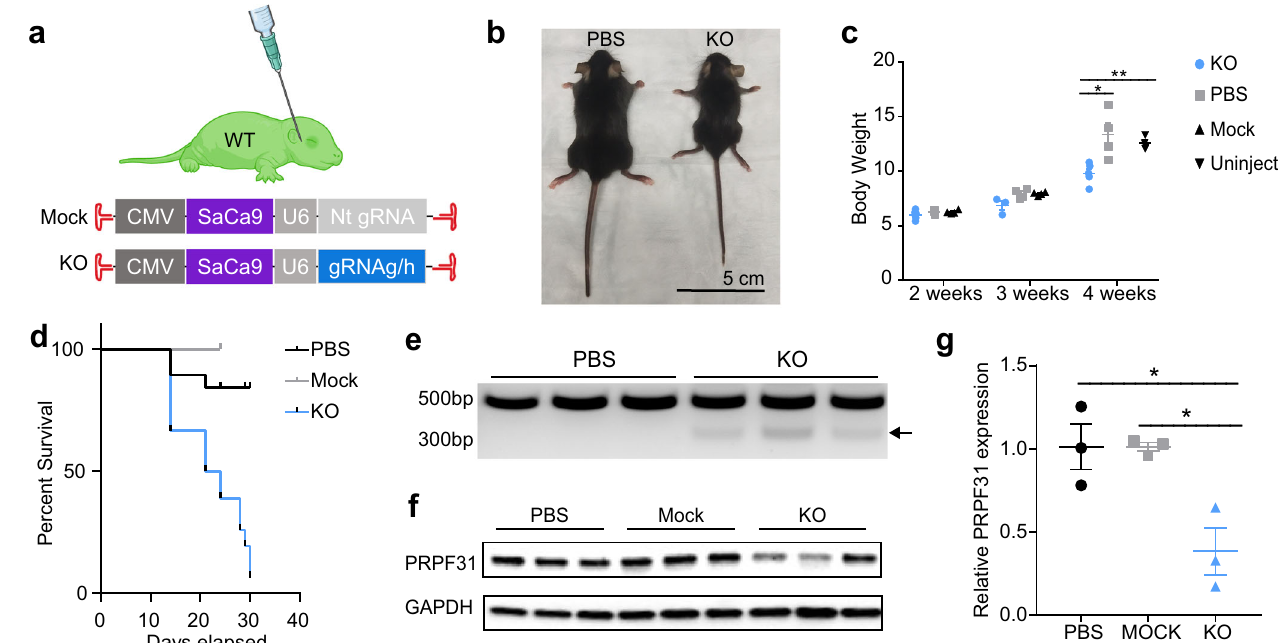
Fig. 6 | Systemic injection of Prpf31-KO vectors to P0 mice. a Illustration of the systemic injection approach. AAV92YF-CMV-SaCas9-U6-gRNAg/h (50 µ l, 1.35E+13 vg/ml,gRNAg:gRNAh=1:1)wasdeliveredtoP0WTmiceviafacialveininjection.An equal volume of PBS or mock Cas9 vector AAV92YF-CMV-SaCas9-Nt gRNA (3.82E+13vg/ml) was injected to litter mates as control. b Images of 2 male mice taken 4 weeks (p.i.) Compared with PBS-injected control litter mate, KO pups developed abnormally. c Body weights of PBS, Mock and KO vectors injected and uninjectedpups2 – 4weeks(p.i.)TheKOgrouphadsigni fi cantlylowerbodyweights ( n =3 – 6). Males and females were evenly distributed in each group. (2 weeks: PBS n =5, Mock n =4, KO n =6; 3 weeks: PBS n =4, Mock n =4, KO n =3; 4 weeks: PBS